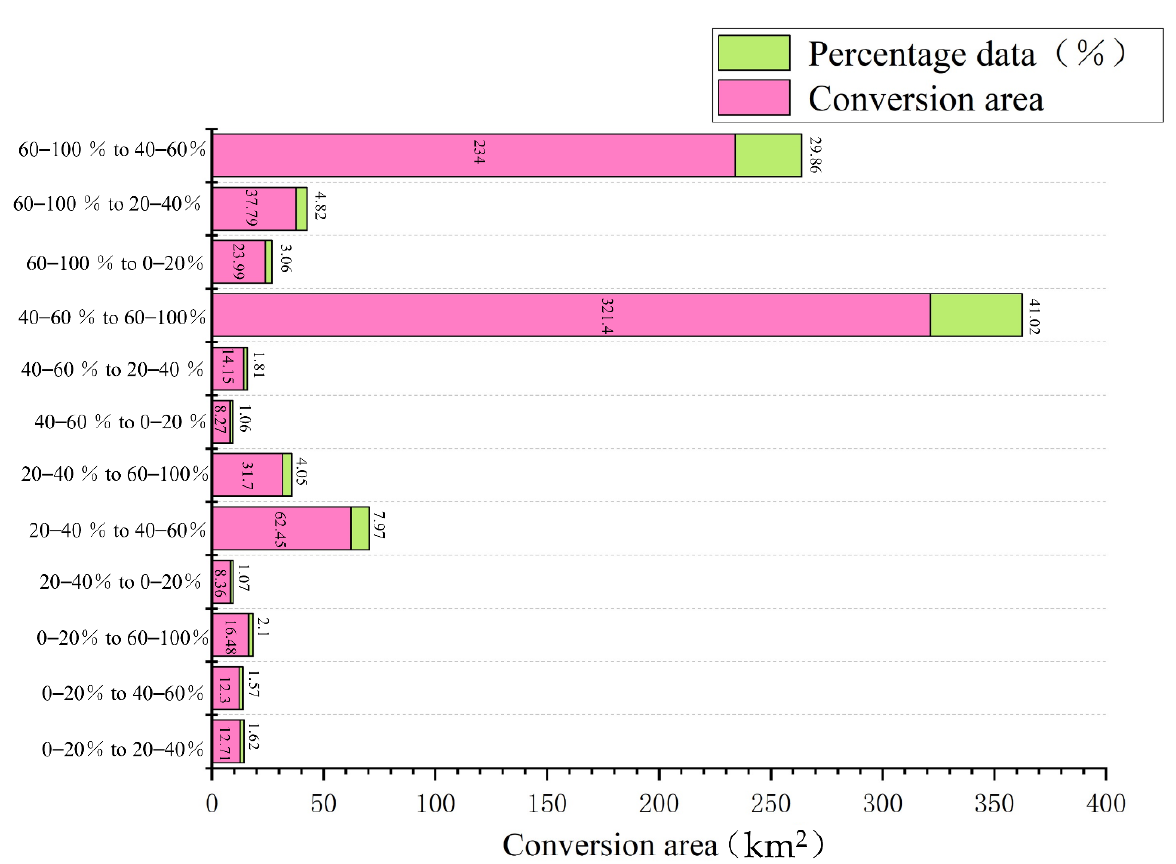
14 of 21 Figure 10. Changes in different vegetation coverage intervals in the past 30 years from 1989 to 2021 ( A ): the area of 1989 0 – 20% vegetation coverage change to 2021 20 – 40% vegetation coverage; ( B ): the area of 1989 0 – 20% vegetation coverage change to 2021 40 – 60% vegetation coverage; ( C ) : the area of 1989 0 – 20% vegetation coverage change to 2021 60 – 100% vegetation coverage; ( D ): the area of 1989 20 – 40% vegetation coverage change to 2021 0 – 20% vegetation coverage; ( E ): the area of 1989 20 – 40% vegetation coverage change to 2021 40 – 60% vegetation coverage; ( F ): the area of 1989 20 – 40% vegetation coverage change to 2021 60 – 100% vegetation coverage; ( H ): the area of 1989 40 – 60% vegetation coverage change to 2021 0 – 20% vegetation coverage; ( I ): the area of 1989